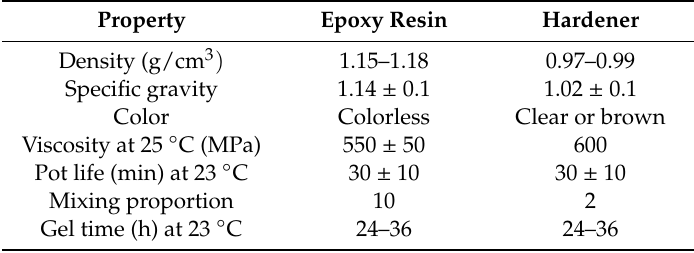
Table 2. Mechanical properties of epoxy resin and hardener [31].